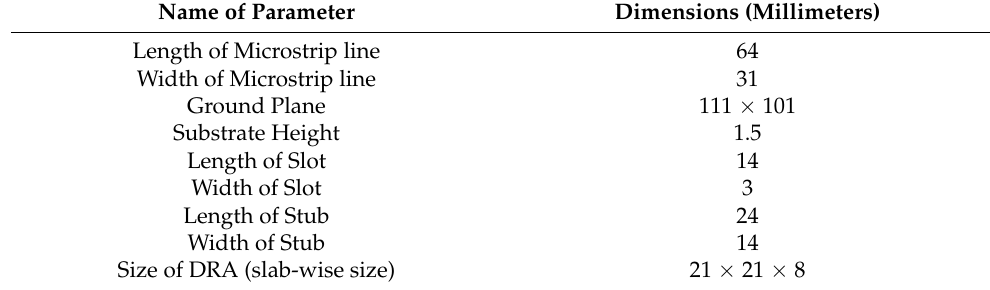
Figure 7. The hardware of 3.5 GHz aperture coupled MSDRA.